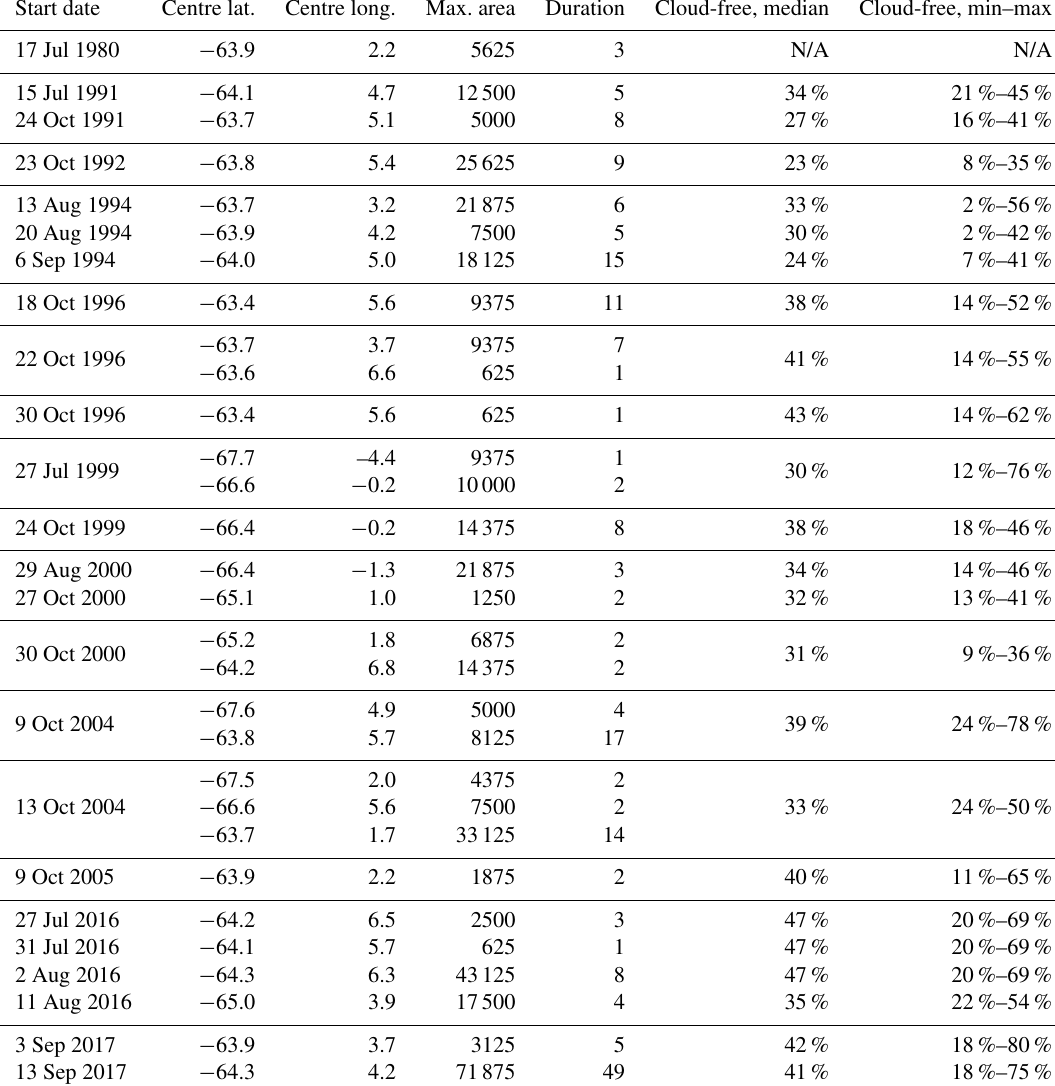
Table B1. Characteristics of the events detected in Sect. 3.1, with sea ice concentration < 60% criterion: start date, latitude (lat., in degree North) and longitude (long., in degrees east) of the centre, maximum area (in km 2 ) and duration (in days). The last two columns are the median percentage of cloud-free pixels (out of 90000) over the 15d prior to the polynya opening, as well as the minimum–maximum interval of that